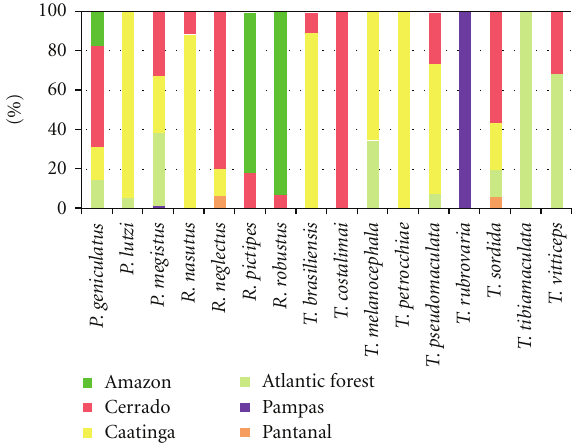
Figure 1: Relative occurrence of 16 species of triatomines across biomes, calculated based on proportions of known occurrences falling in each